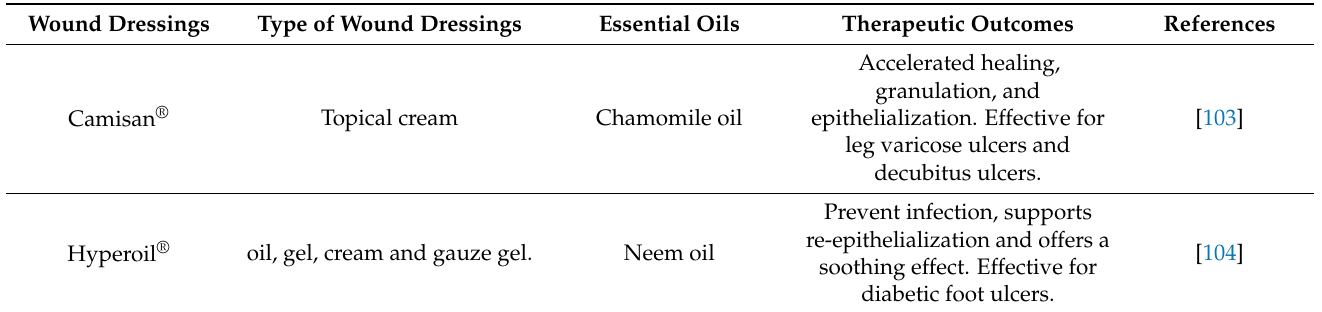
Table 2. Commercially available wound dressings loaded with essential